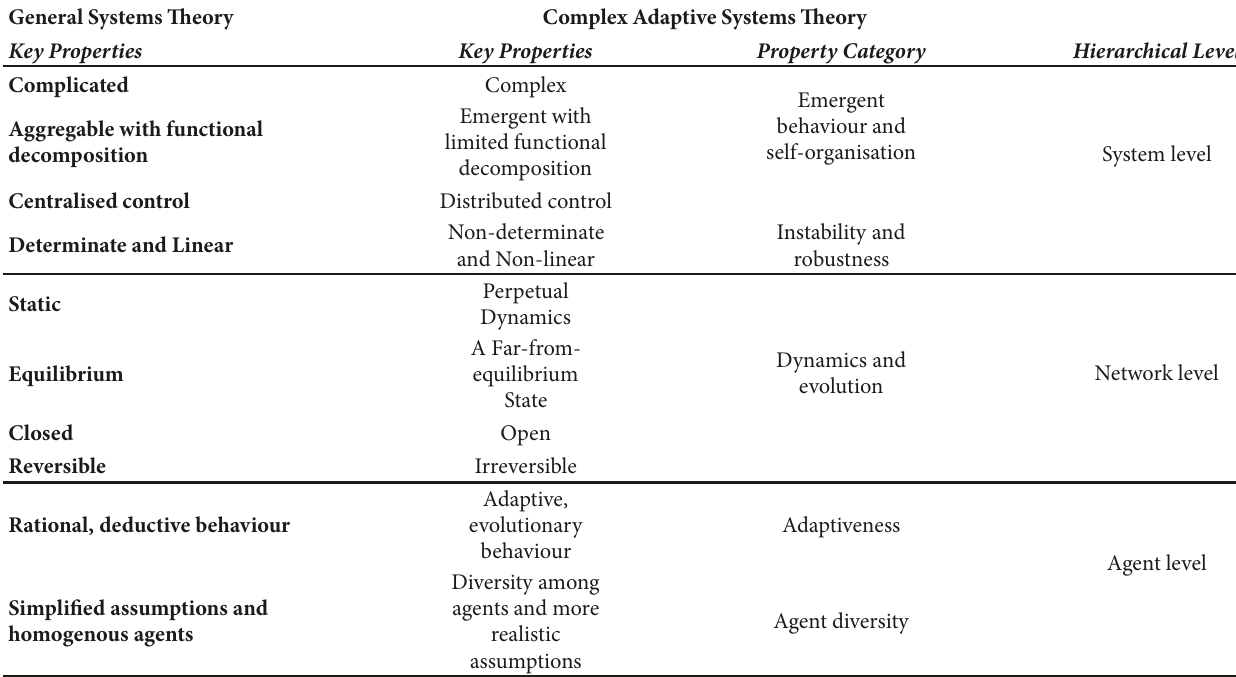
Table 2: Properties of general systems and complex adaptive systems [10, 12,